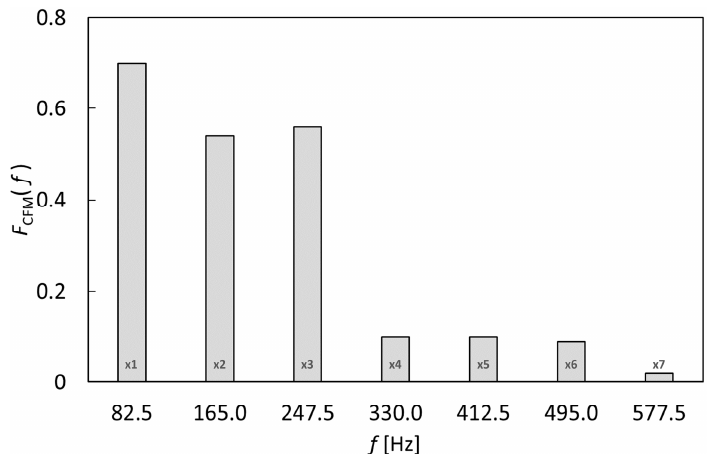
Figure 13. Harmonics magnitude and frequencies obtained by FFT of the force signal.